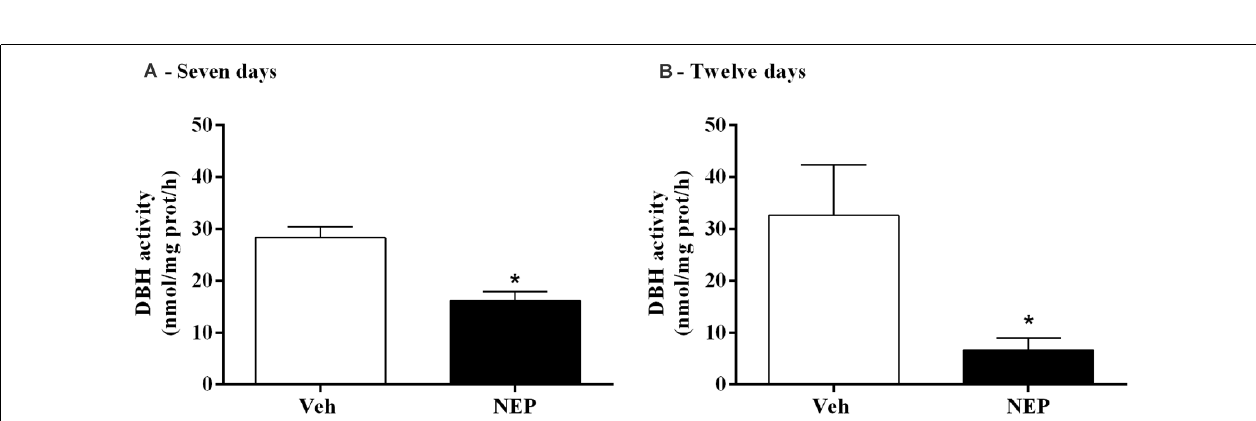
FIGURE 5 | DBH activity in the adrenal gland after treatment with nepicastat (A) 7 and (B) 12 days after post-traumatic stress disorder (PTSD) induction. Values are means ± SEM of 5–8 mice per group. Veh, mice in the PTSD-group and treated with vehicle; NEP, mice in the PTSD-group and treated with nepicastat; *, significantly different from correspondent values in mice in the PTSD-group and treated with vehicle ( p < 0.05).